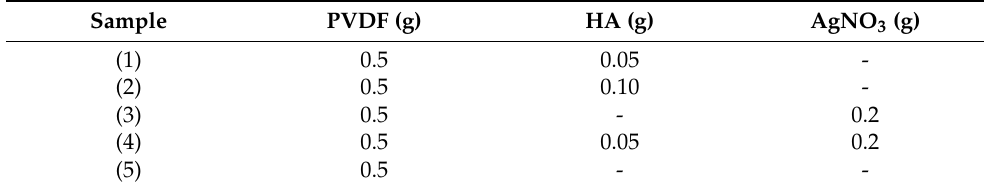
Figure 3. Schematic of synthesis route and fabrication of composites solid films. Table 1. Values of precursor for preparing samples.